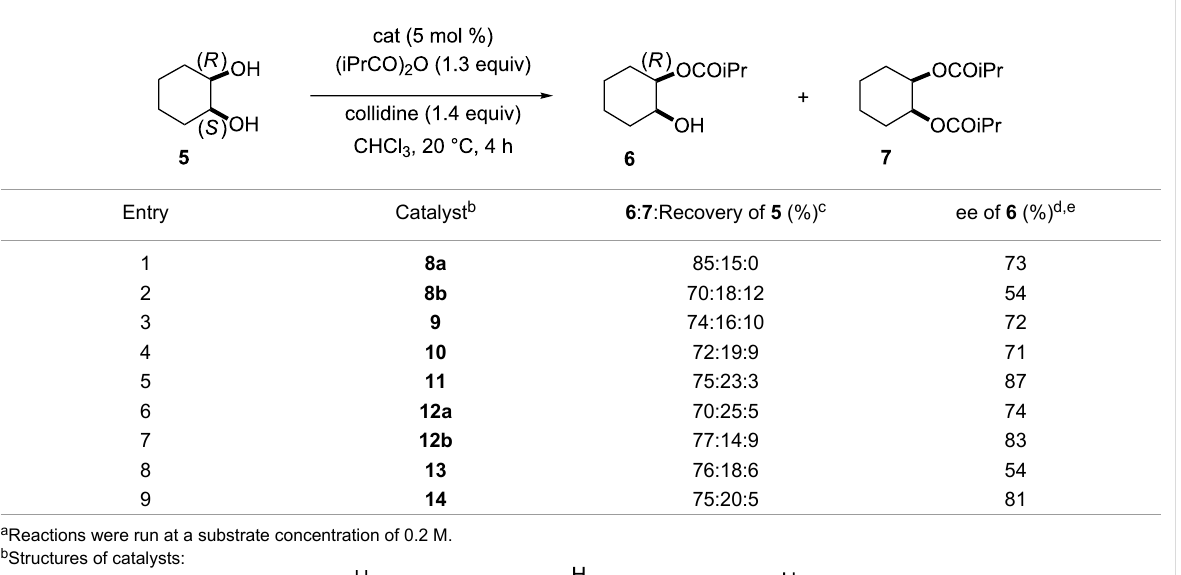
Table 1: Effects of the catalysts’ side chains on the asymmetric desymmetrization of meso -1,2-cyclohexanediol ( 5 ).